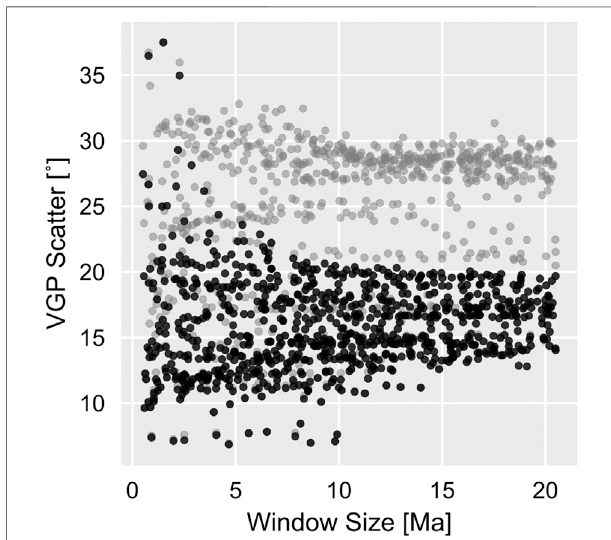
FIGURE 3 | Variation in VGP scatter across intervals of increasing window sizeforAustralianVGPs during theCenozoic.Blackpoints are fi ltered with a variable VGP cutoff, gray points are un fi ltered (each point is randomly jittered about their window size to prevent overplotting by Ma). The wide range of values at interval sizes ( < 10 Ma) indicates that for some intervals, PSV is not adequately sampled, while the gradually increasing median values for S above 10 Ma is indicative of APW being averaged, together with PSV when intervals this large are used.